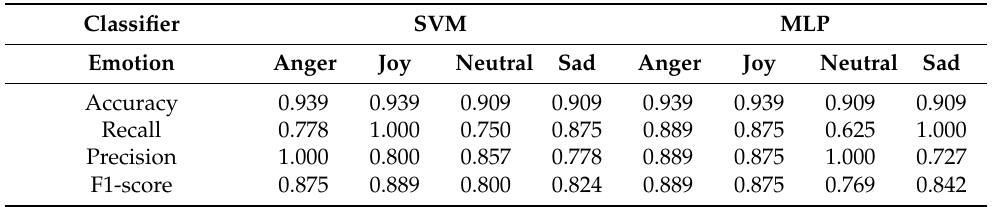
Table 8. Per-class scores in automatic multi-class classification, eGeMAPS feature set, testing on 33 samples from subjective